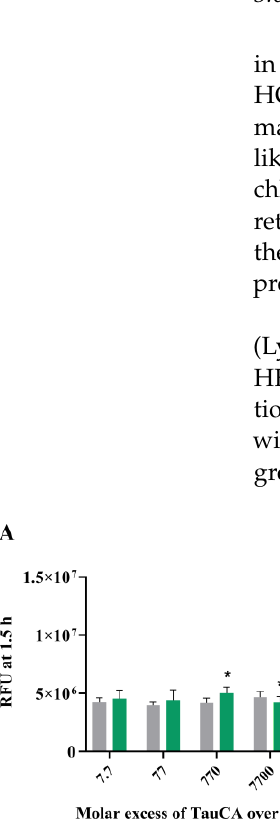
Figure 8. Effects of different concentrations of amino acid chloramines (green bars) formed on taurine (TauCA) (Panel ( A )), lysine (LysCA) (Panel ( B )) and histidine (HisCA) (Panel ( C )), and parent amino acids (gray bars labeled ck), on proMMP9 activation, as determined by cleavage of a profluorescent peptide and the determination of the consequent fluorescence. Preformed chloramines were generated by adding HOCl to a 5-fold excess of taurine and N α -acetyl-lysine, or a 2-fold excess of N α -acetyl-His-NHMe, in 5 mM sodium phosphate buffer (pH 7.0). Chloramine yields were then quantified using TNB assay (see Section 2), and the indicated concentrations of chloramines were then incubated with proMMP9 (13 nM) for 24 h at 37 °C before the quantification of the enzyme activity by fluorescence spectroscopy. Data are presented as the mean RFU values ± SDs from three technical replicates from each of the three biological replicates for the chloramine-containing samples versus the corresponding parent amino acid-treated controls (labeled “ck”). Statistical analysis was performed using unpaired t tests with Welch’s correction, with the statistical significance between the paired samples indicated by * .